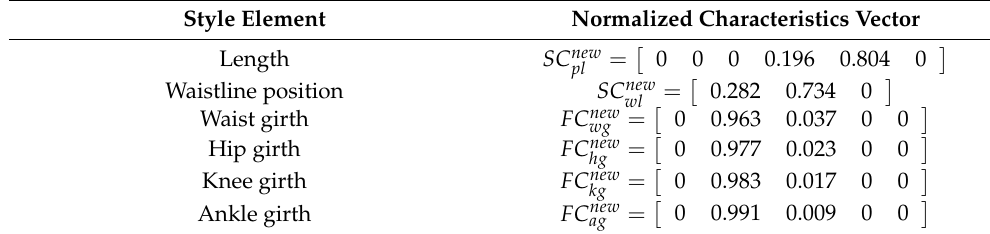
Table 7. New normalized style and garment fit level